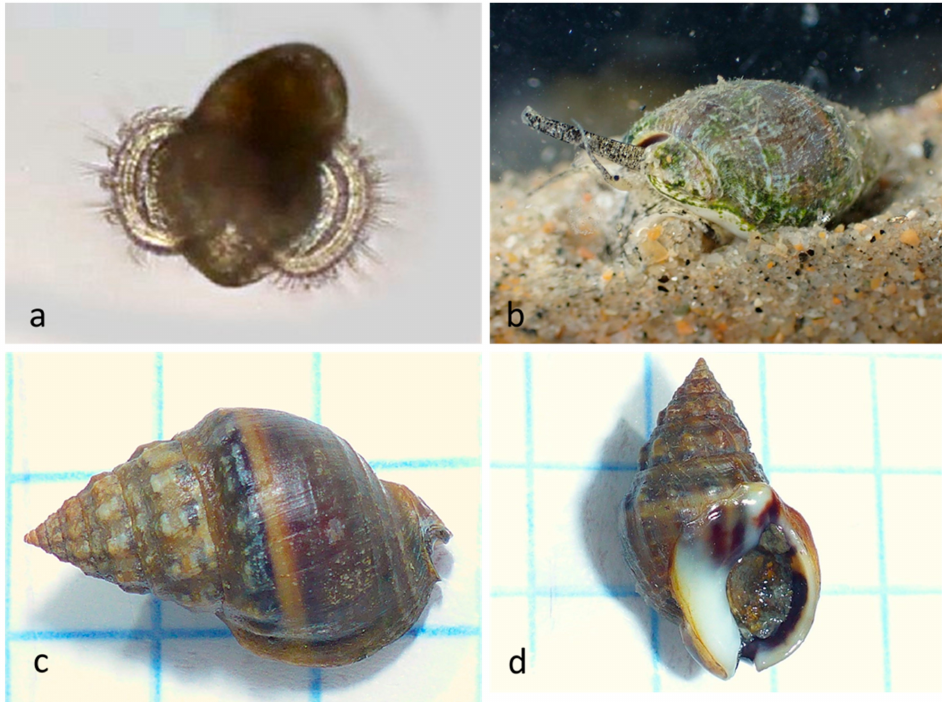
family members Poulson’s Dwarf Triton, Roperia poulsoni , and Festive Murex, Pteropurpura